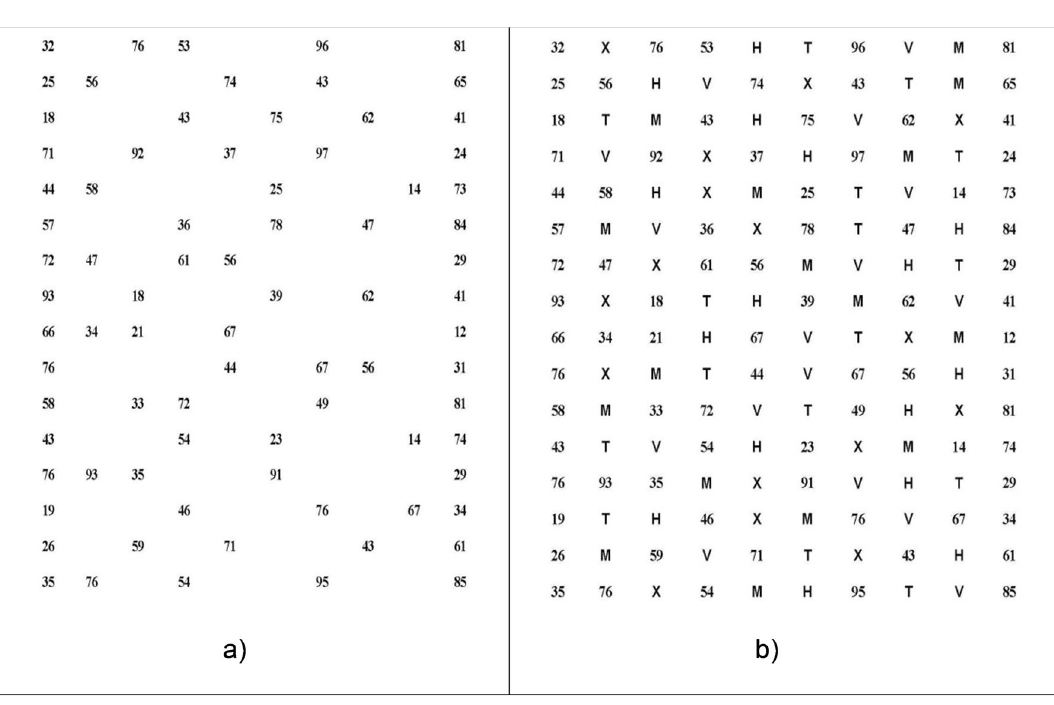
Figure 6. Horizontal (H) and horizontal with distractors (Hd) sheets of the ADEMd